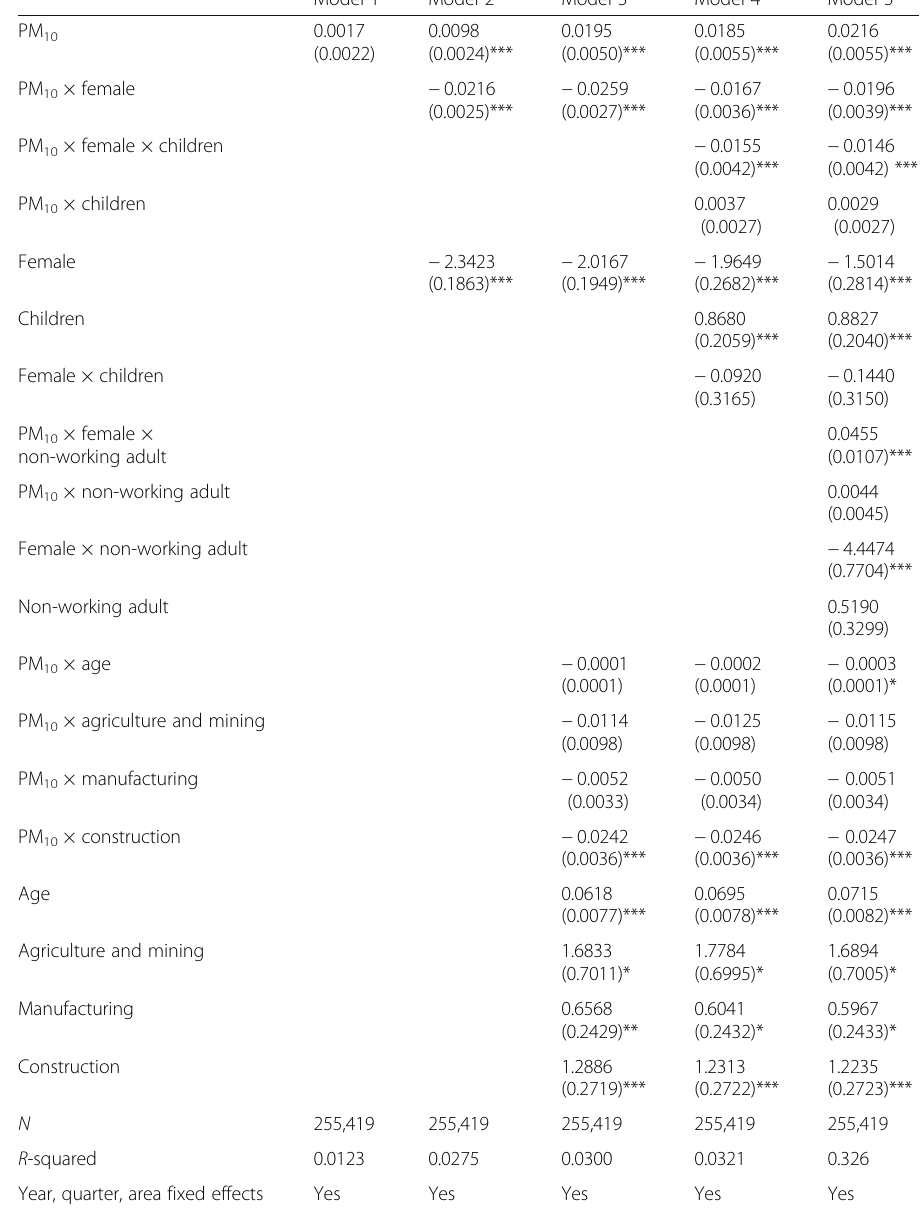
Table 3 The relationship between hours worked, PM 10 , gender and childcare in